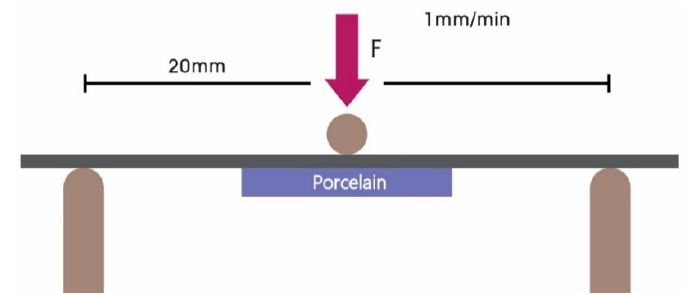
Figure 3. Schematic diagram of the three-point bending test.